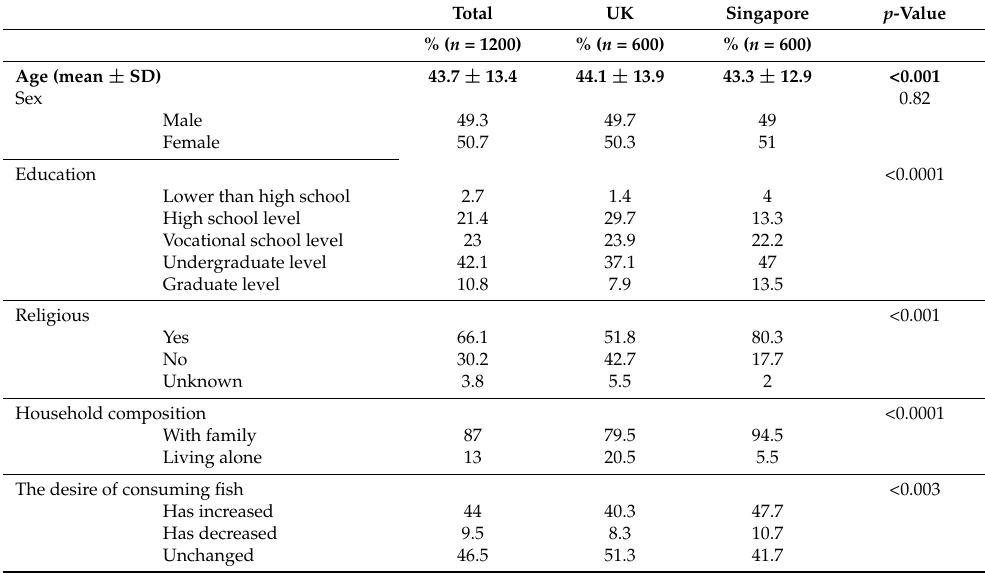
Table 2. The socio-demographic characteristics and dependent variables of the study population.